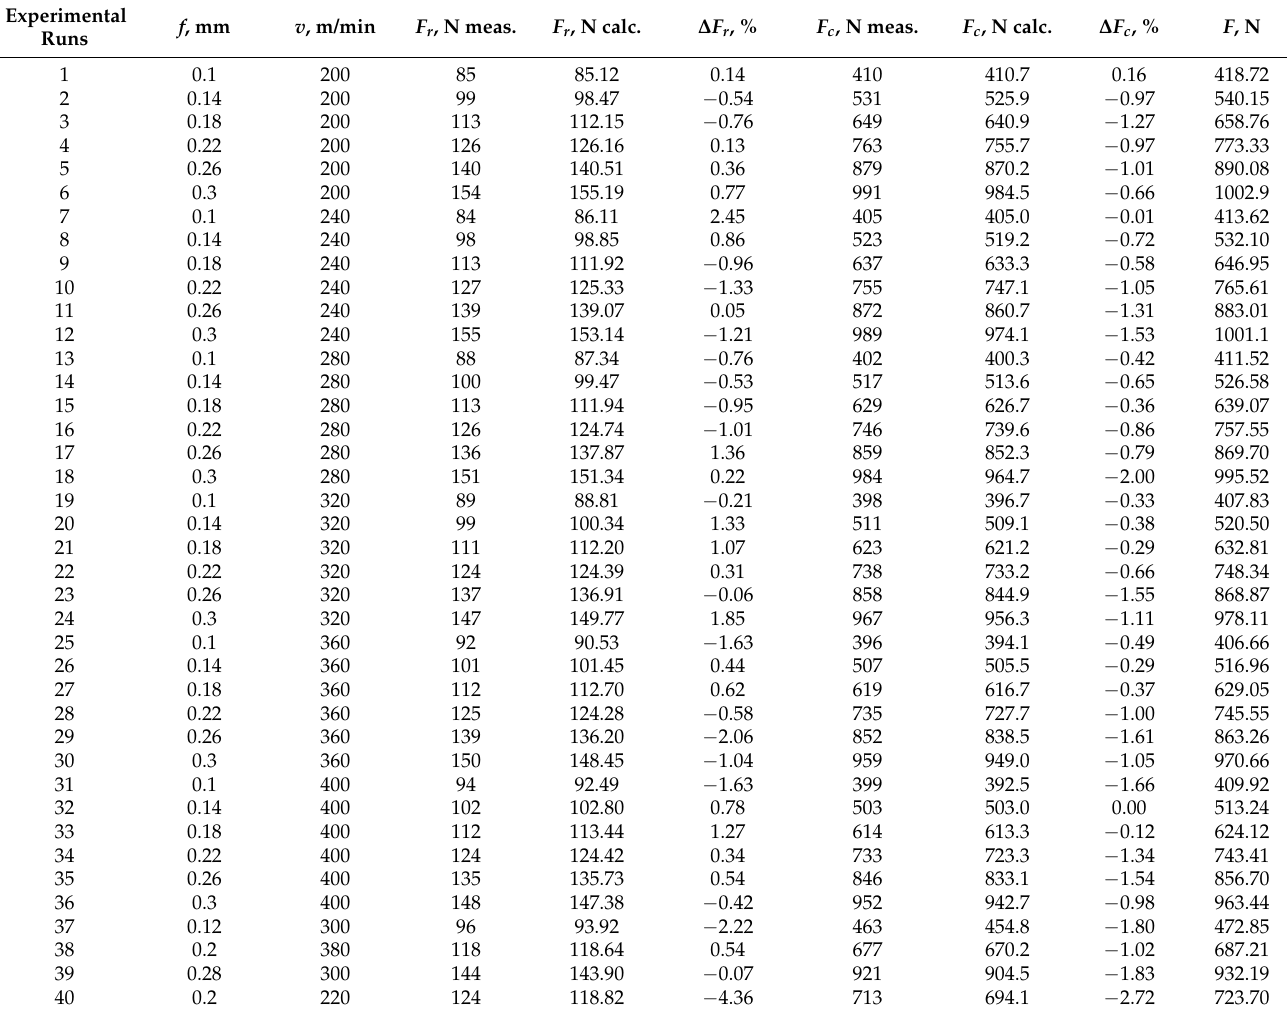
Figure 4. Feed-cutting speed parameter combinations for force measuring. Table 1. Measured and calculated forces.